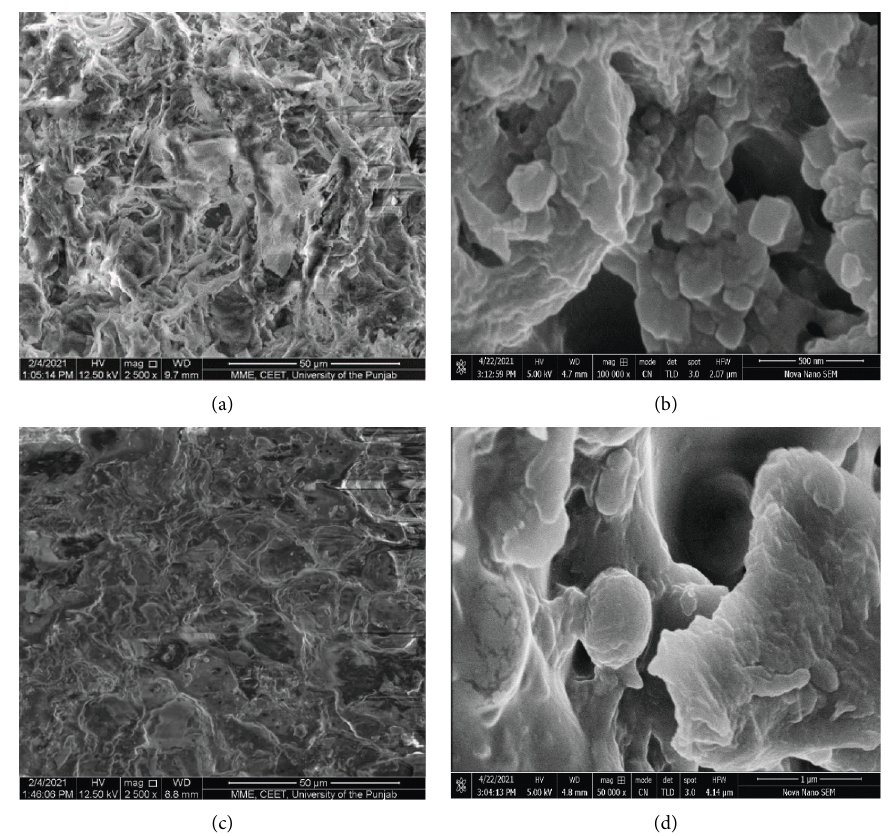
Figure 8: A comparative SEM evaluation. (a) TP, (b) C-TP, (c) CP, and (d)